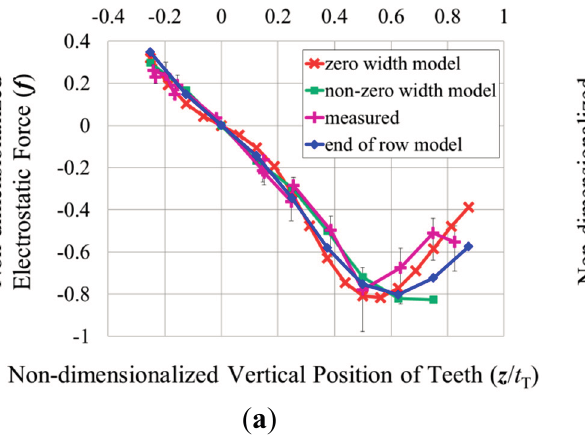
Figure 10. Comparisons of three different predictions of the electrostatic forces to those measured in ( a ) a vertical comb drive that has shorter movable teeth than fixed teeth (with tooth dimensions of w / t T = 0.241, g / t T = 0.296, and t S / t T = 0.365) and ( b ) a vertical comb drive that has fixed and movable teeth of the same size ( w / t T = 0.234, g / t T = 0.300, and t S / t T =